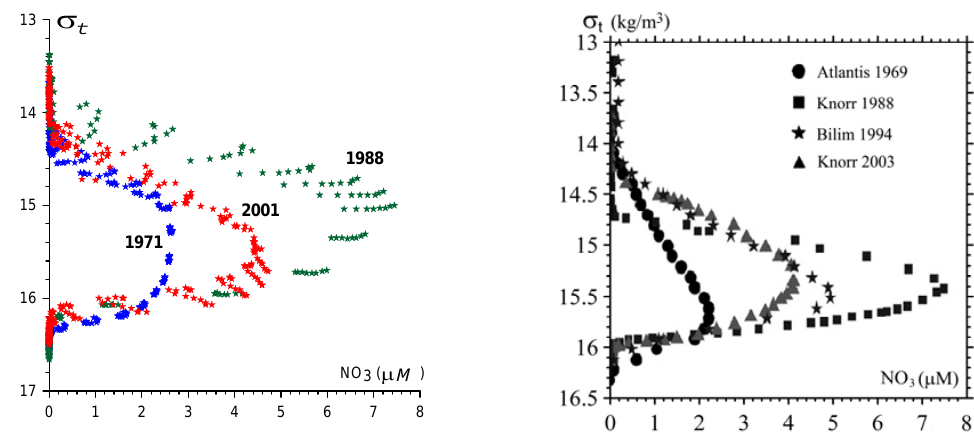
Fig. 22. Derived from modeling nitrate profiles (in µM) versus sigma-t (in kgm − 3 ) for the central western gyre (left) and nitrate profiles Figure 22 Derived from modeling nitrate profiles (in M  ) versus sigma-t (in kg m-3 ) for the measured by cruise vessels (Oguz and Gilbert, central western gyre (left) and nitrate profiles measured by cruise vessels.